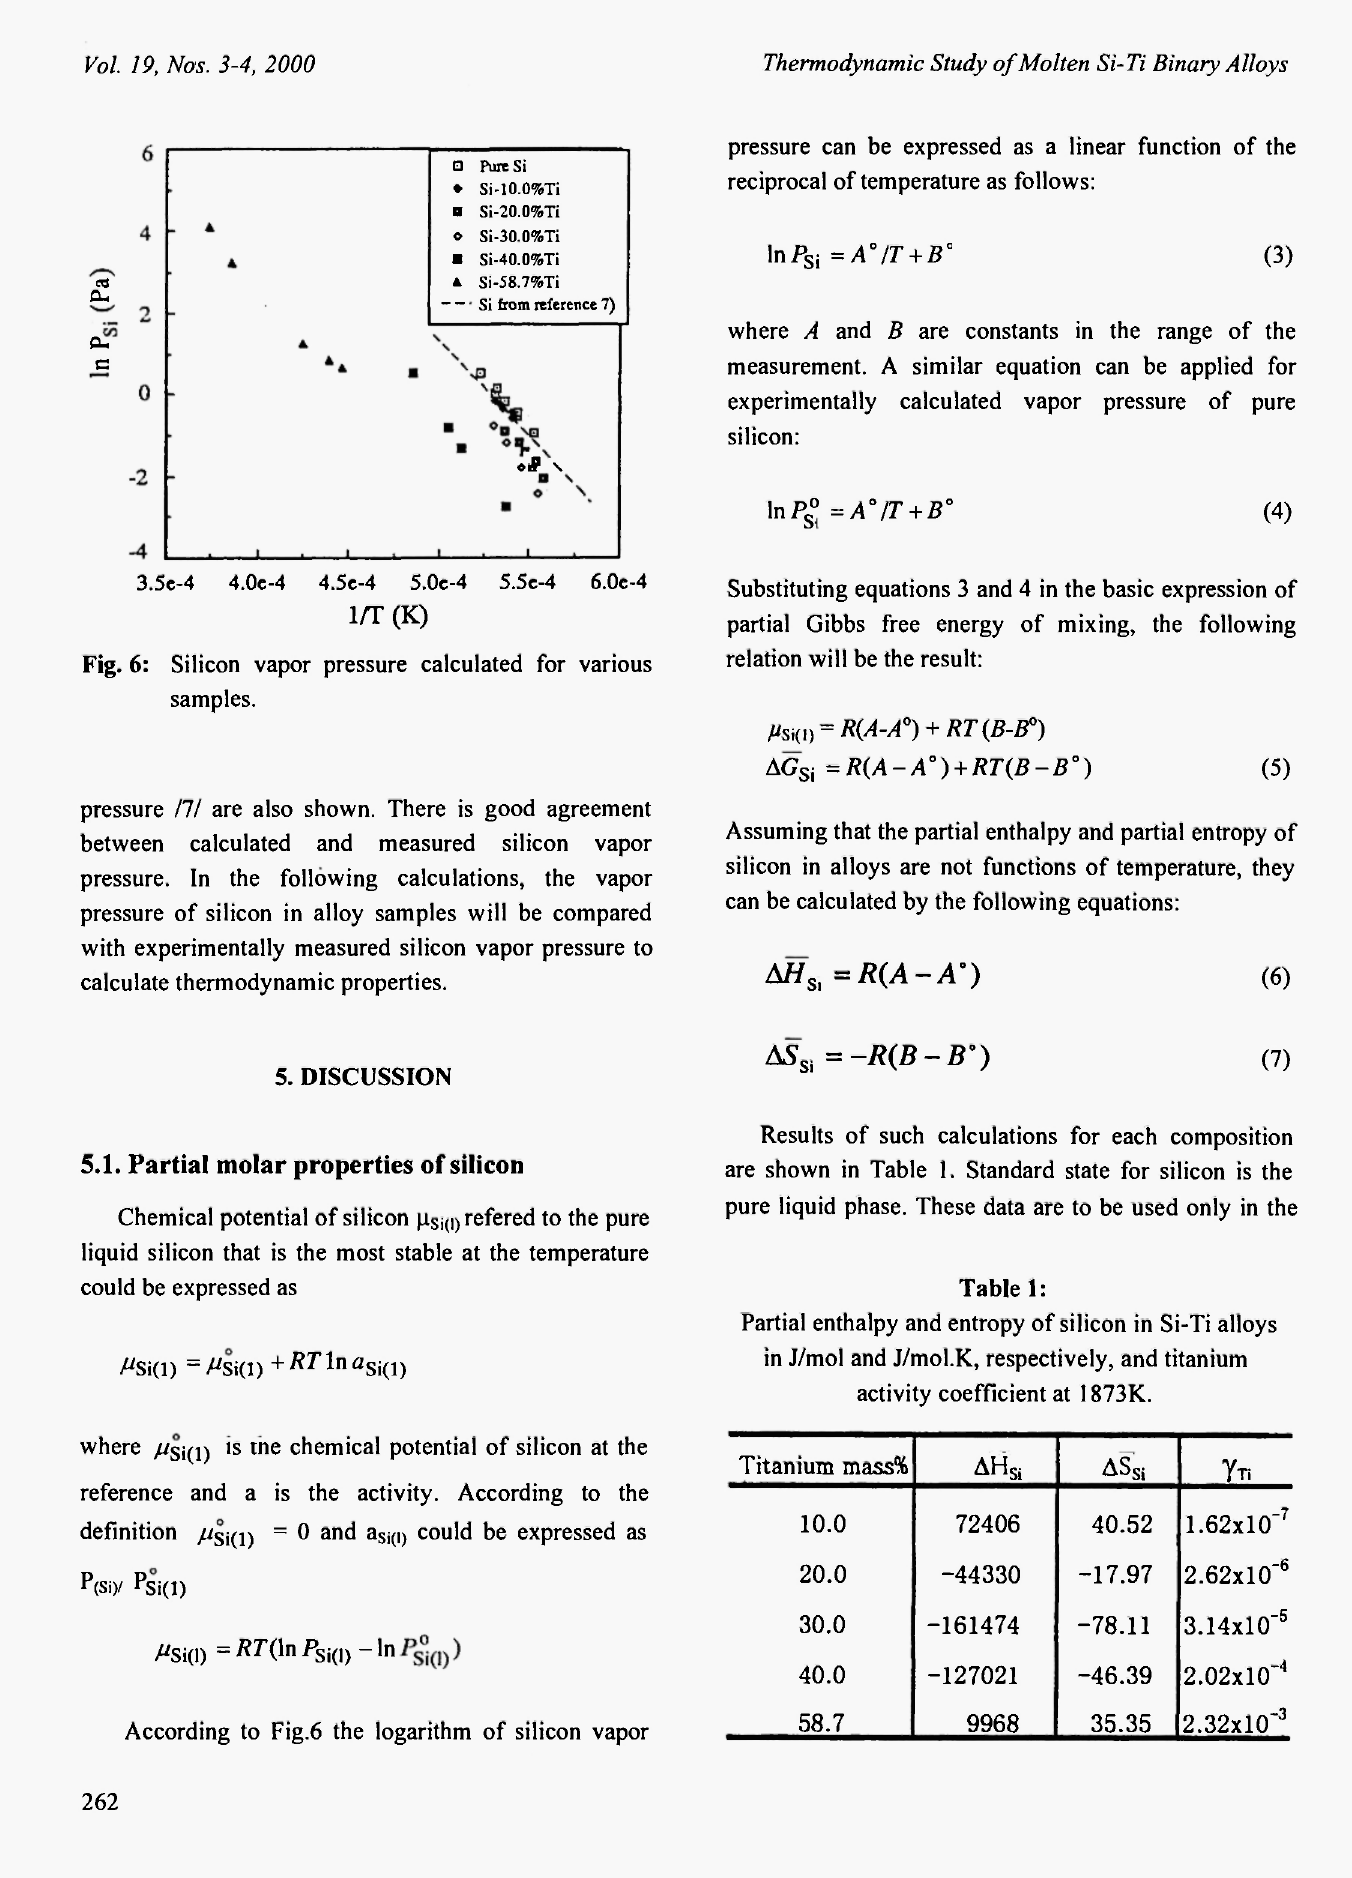
Partial enthalpy and entropy of silicon in Si-Ti alloys in J/mol and J/mol.K, respectively, and titanium activity coefficient at